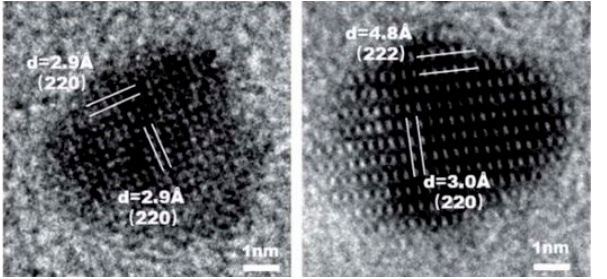
Figure 4. High-resolution Transmission Electron Microscopy (TEM) images showing lattice fringes of the magnetite cores (adapted from [50] with permission from The Royal Society of Chemistry 2019).